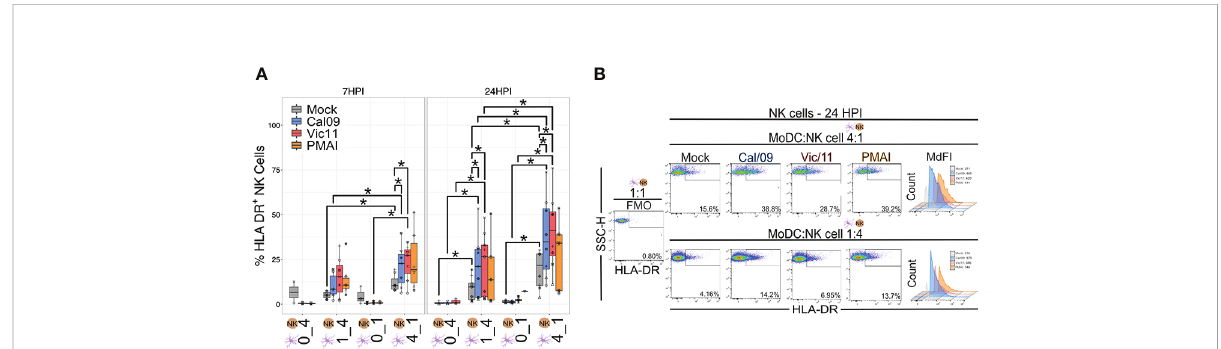
FIGURE 3 NK cells express HLA-DR after co-culture with IAV-exposed MoDCs. (A) Summary plot of the frequency of HLA-DR + NK cells after culture alone or after 6 h ( n = 7) or 23 h ( n = 6-9) co-culture with mock-treated or Cal/09- or Vic/11-exposed MoDCs at an MOI of 3 as assessed by fl ow cytometry using an antibody speci fi c to HLA-DR. In the NK cell-only conditions (0:1, 0:4), in fl uenza virions were added concurrently with the NK cells. (B) Representative fl ow plot of the percentage of HLA-DR + NK cells and MdFI of HLA-DR on NK cells after 23 h co-culture with Cal/09- or Vic/11- exposed MoDCs (MOI = 3) at a MoDC to NK cell ratio of 4:1 (top panel) or 1:4 (bottom panel). PMA/I treatment for 6 h served as a positive control. The same shape between conditions indicates that the data point is derived from the same donor. * p < 0.05, Wilcoxon signed-rank